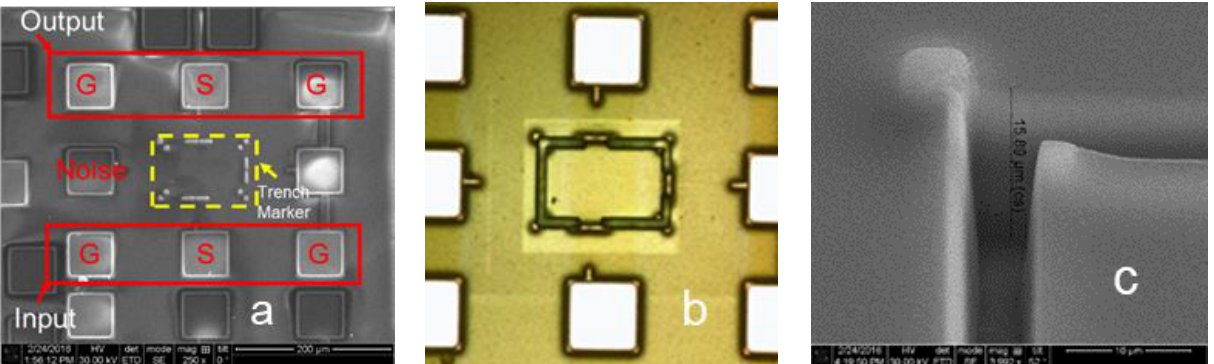
Figure 11. SEM photos for the in-BEOL metal wall structure in an amplifier IC designed in a 180 nm SOI CMOS: ( a ) MPW die showing the planned metal wall enclosure (marked in yellow dashed line), ( b ) the metal wall structure formed in post-CMOS fabrication, and ( c ) zoom in of the deep trench before metal filling [34].